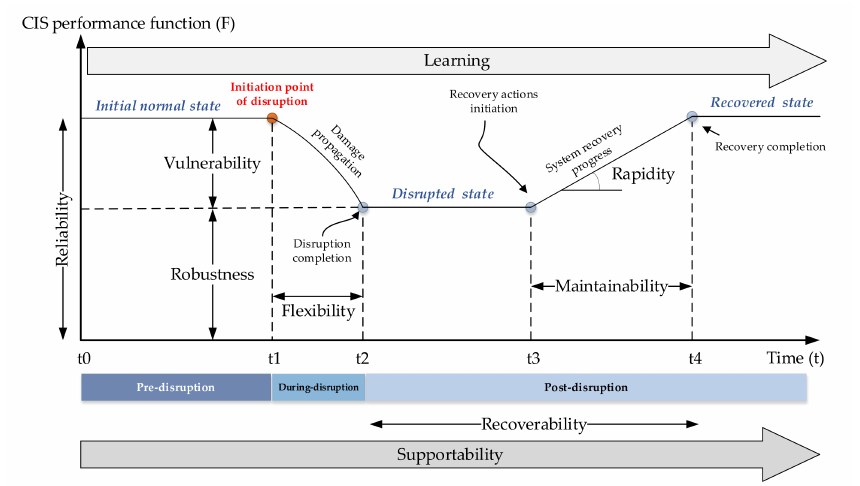
Figure 1. Resilience concept